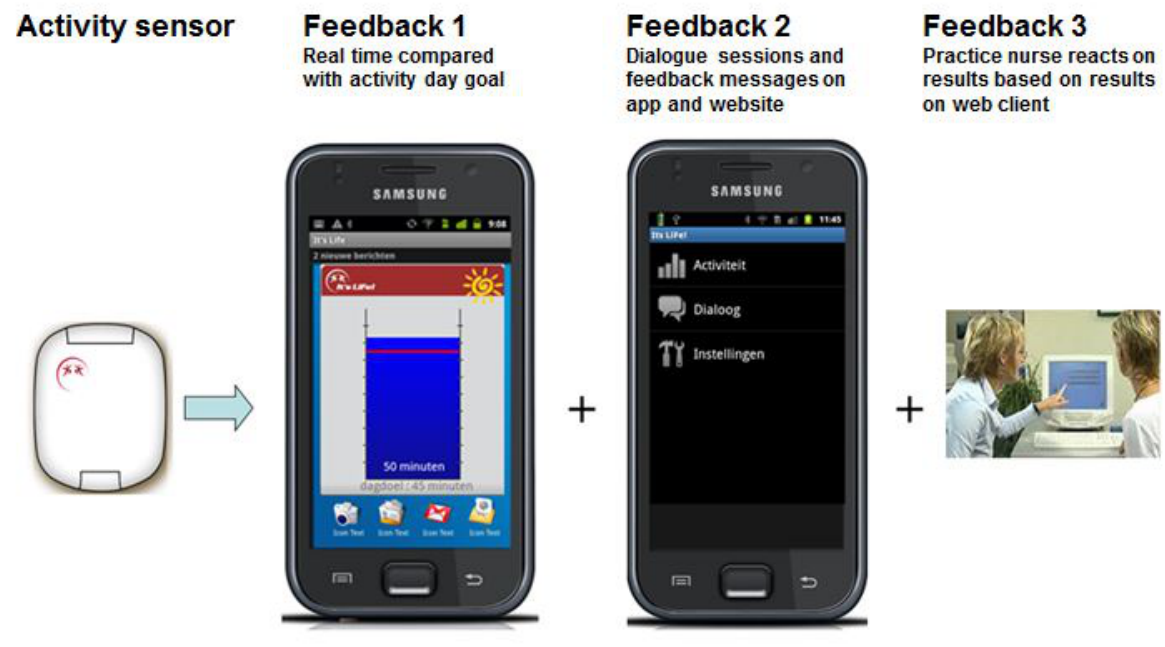
Figure 2. The monitoring and feedback tool that was developed, based on the requirements of the end-users. The tri-axial activity sensor is connected via Bluetooth to the smartphone. The smartphone gives directly visible feedback about the amount of activity in a bar chart, which dynamically fills up. When the goal (indicated by the red line) has been reached, a sun rises. In the app and on a secure webpage, people can see their activity history and answer dialogue sessions and read feedback messages generated by the system. The practice nurse can monitor the results of all patients on the secure web page to discuss during patient